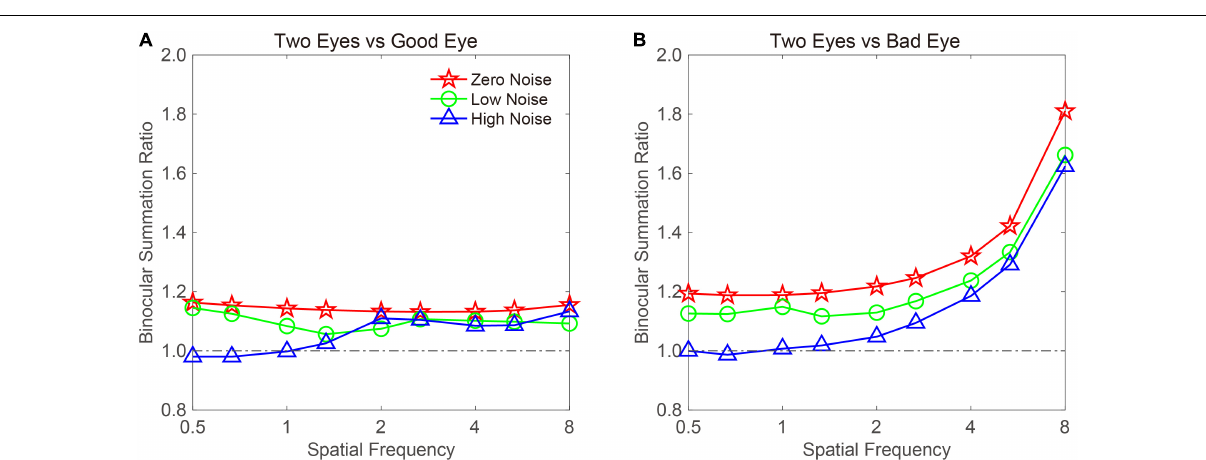
When the bad eye was considered as the standard eye, the BSR vs. the spatial frequency curve was plotted ( Figure 5B ). The BSR curve started horizontally at low spatial frequencies